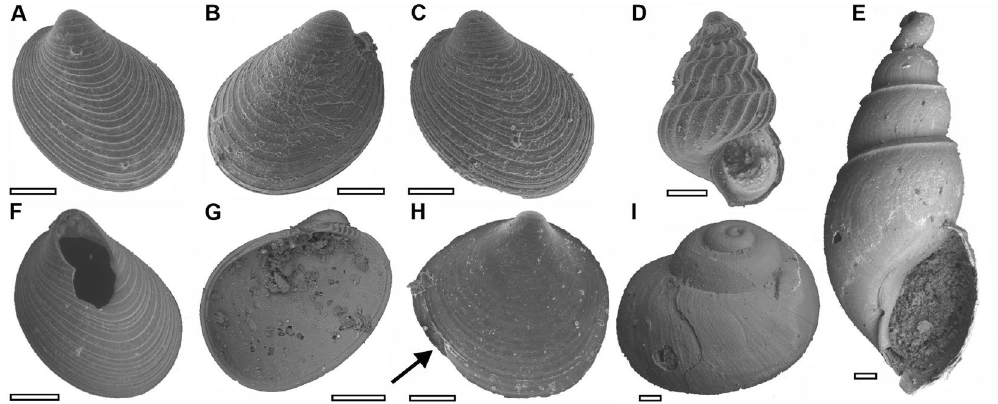
Figure 2. Scanning electron micrographs of representatives of the different states of shell preservation observed in this study. ( A – C , F , G ) Nucinella taylori Foster et al. (2017) 25 : ( A ) NHMUK PI MB 1339(29), pristine condition, ( B , C ) with dissolution marks, ( B ) NHMUK PI MB 1343(9), ( C ) NHMUK PI MB 1339(80), ( F ) NHMUK PI MB 1342(34), broken/damaged, ( G ) NHMUK PI MG 1587(5), dissolution marks on the internal side of the shell. ( D ) Pseudozgopleuridae indet., NHMUK PI MG 1581(7), pristine condition, ( E ) Sinuarbullina yangouensis (Pan & Erwin 2001), pristine condition. This specimen was lost when the material was accessioned. ( H ) Pectinidae? indet., NHMUK PI MB 1341(30), morphological deformity (arrow) inferred to have been caused by damage to the shell during growth. ( I ) Glabrocingulum parvum Foster et al. (2017) 25 , NHMUK PI MG 1520, small degree of damage. Scale bars = 100